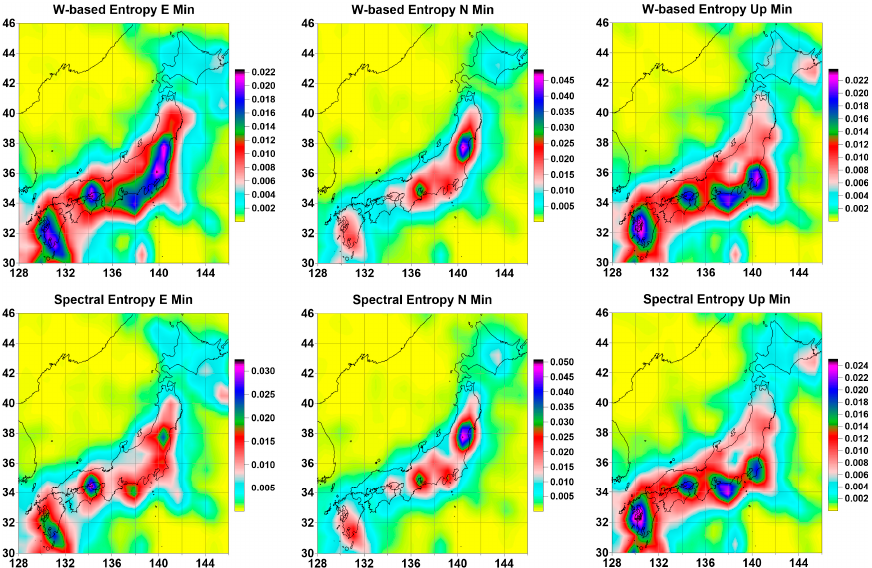
Figure 3. Averaged maps of the distribution of the minimum values of the wavelet-based and spectral entropies of the GPS tremor for the displacement components E, N, and Up on a regular grid of 30 × 30 nodes.